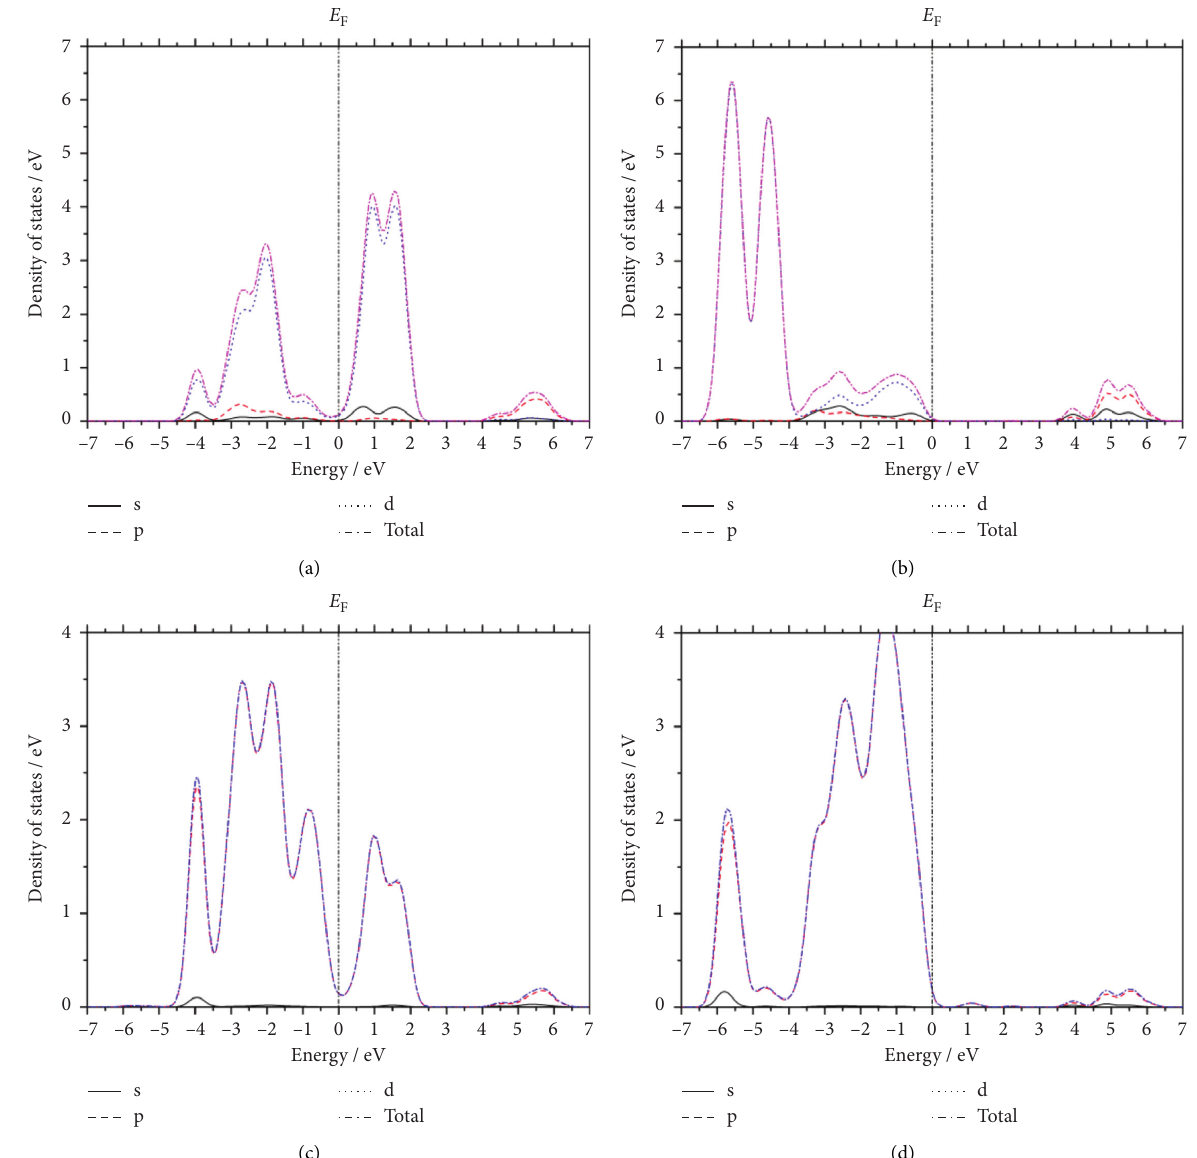
Figure 11: Detailed electron density of states of Co (a for spin-up and b for spin-down) and O (c for spin-up and d for spin-down) for CoO layer within sandwiched Ca 2 Co 2 O 5 crystalline